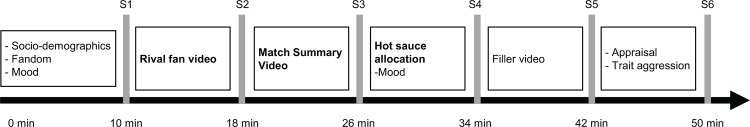
Timeline of the experiment.S = saliva sample.